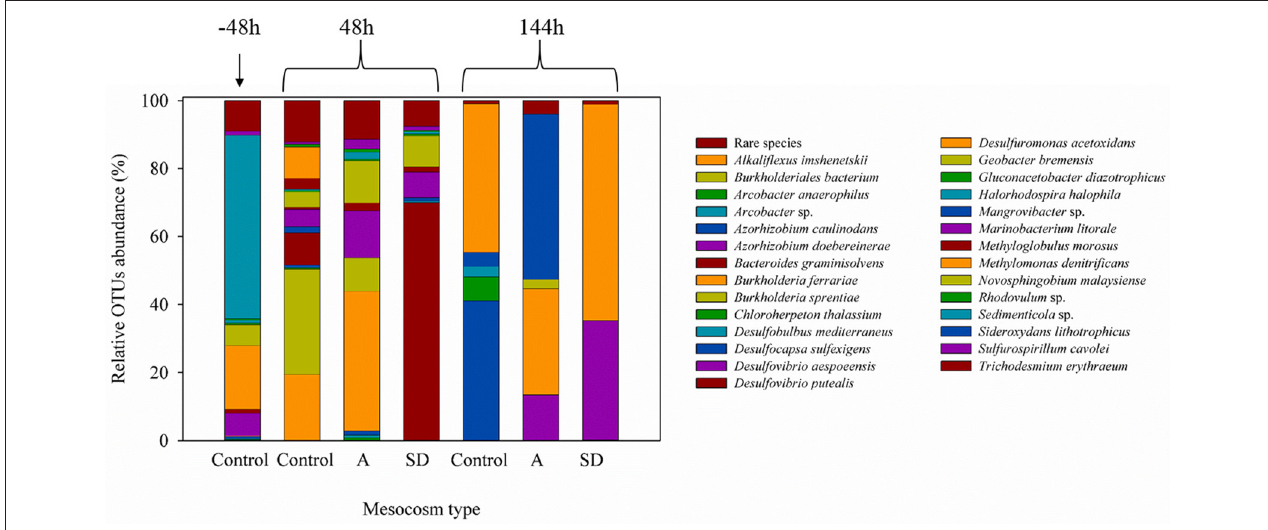
Time after enrichment (h) Incubation under ambient light